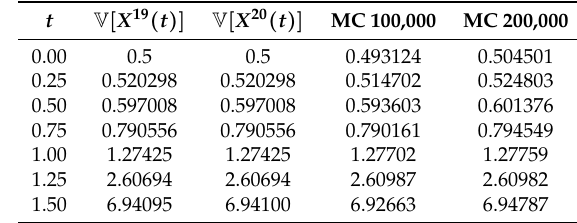
Table 2. Approximation of V [ X ( t )] with N = 19, N = 20, and Monte Carlo simulations. Example